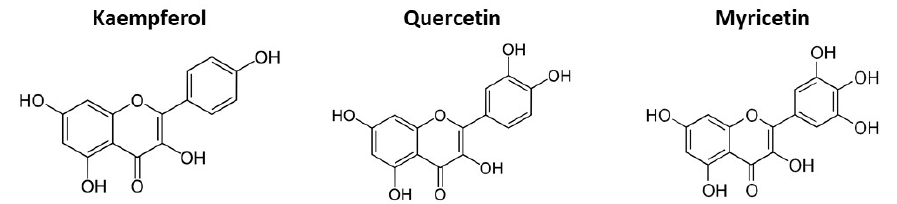
Figure 4. Structures of the major flavonol aglycones.